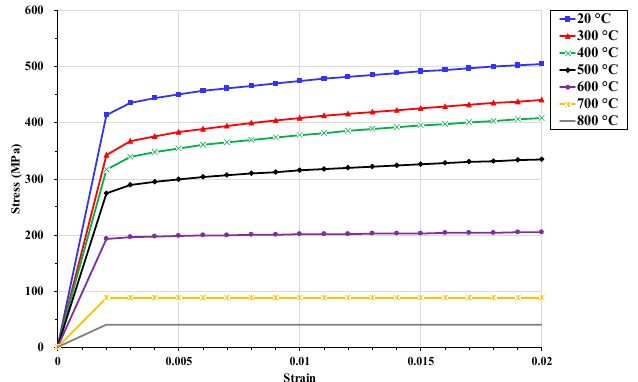
Figure 8. Stress-strain curve for ASTM A572-50 steel.